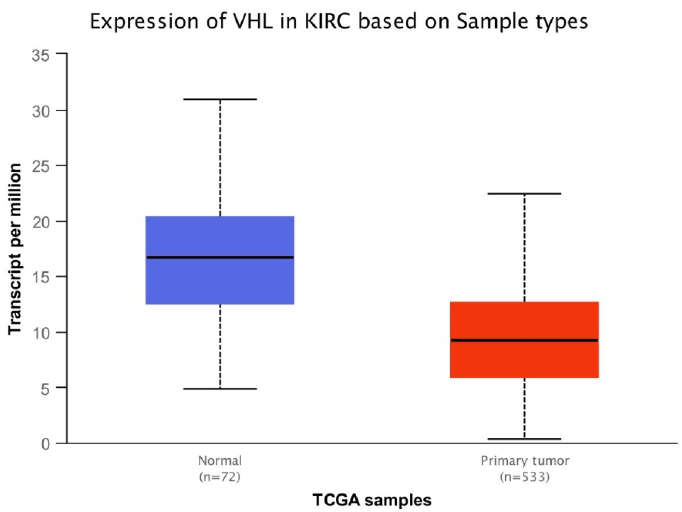
Figure 1. Box-plot analysis showing statistically significant difference ( p < 0.0001) of VHL expression between normal tissue and primary tumor.